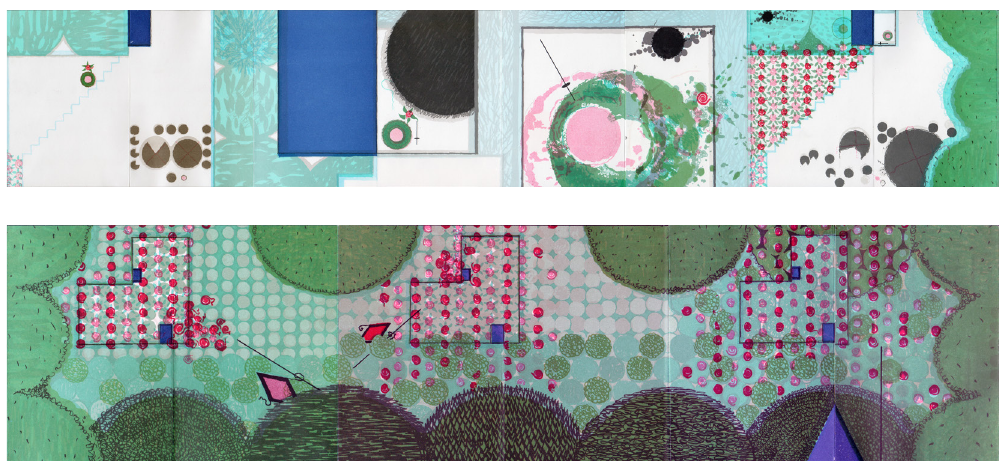
Fig. 17 Warja Lavater, Belle